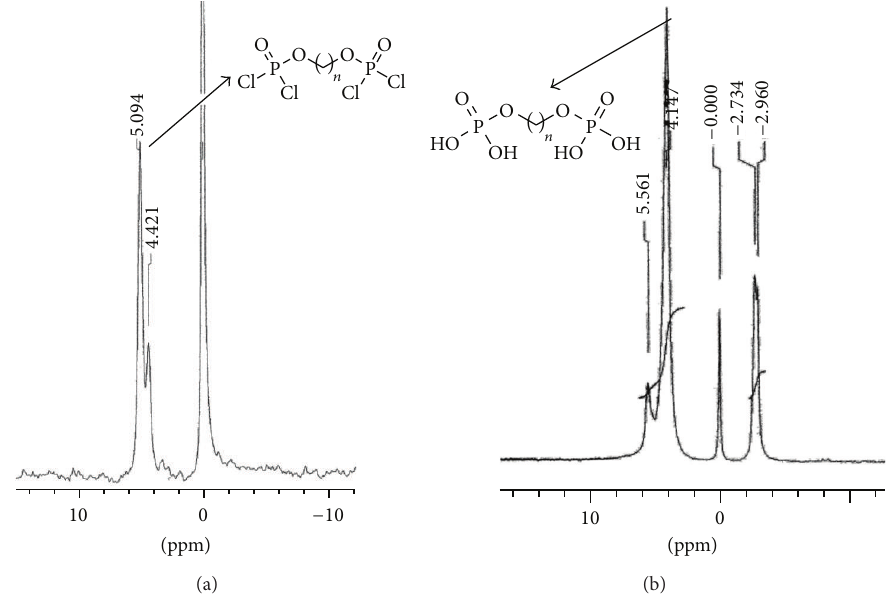
Figure 2: 31 P NMR spectra of the reaction mixtures obtained during the two-step synthesis. (a) Before the hydrolysis (step 1 ). (b) During hydrolysis step 2 (Method 2 ).